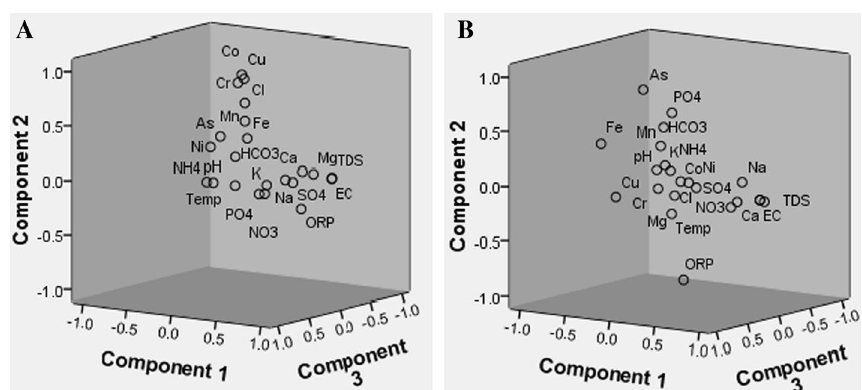
Fig. 5 Rotated loading plots